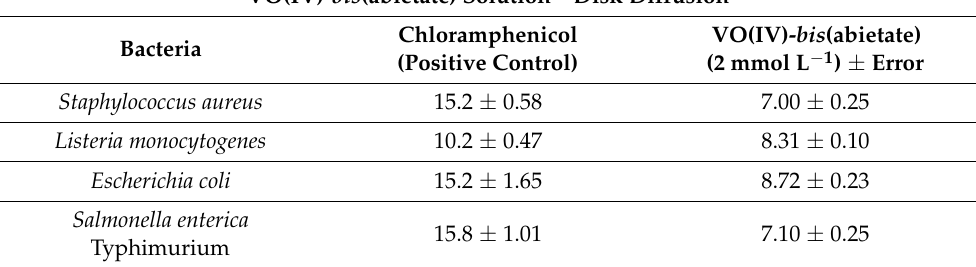
Table 4. Antimicrobial test results through VO(IV)- bis (abietate) solution using the disk diffusion method. Results in